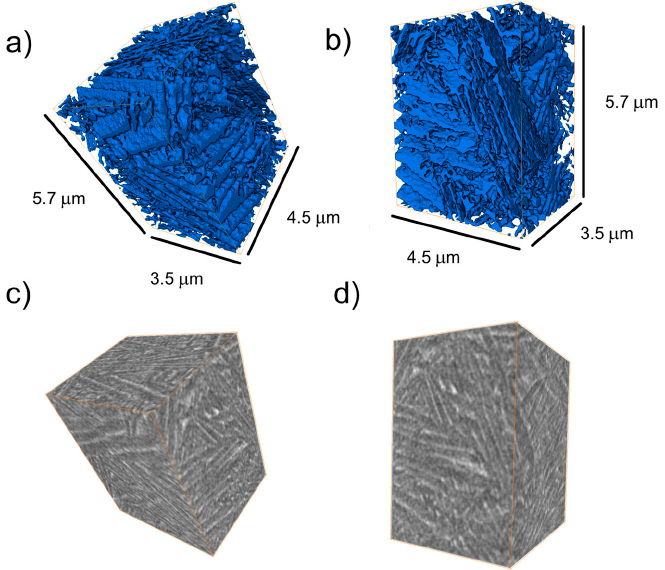
Figure 8. ( a , b ) Illustrative perspectives of the interconnected β network (in blue) segmented from ( c , d ) its associated holographic X-ray computed tomography (HXCT) reconstruction (voxel size = (10 nm) 3 and β matrix in bright grey) corresponding to a representative volume of the microstructure formed at the bottom part of the Ti-64 sample (i.e., z ~ 0 mm) upon SLM.